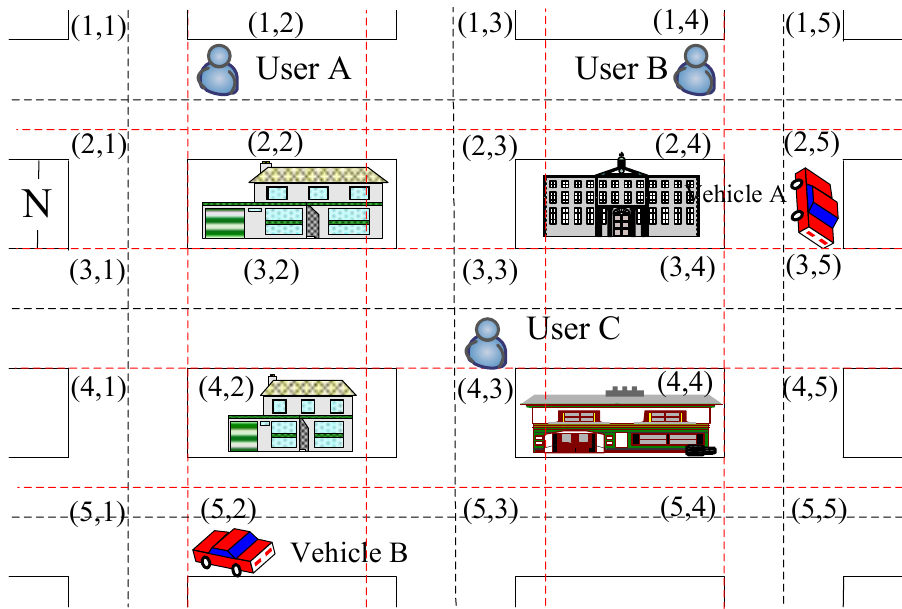
Figure 2. Grid-based partition in the urban